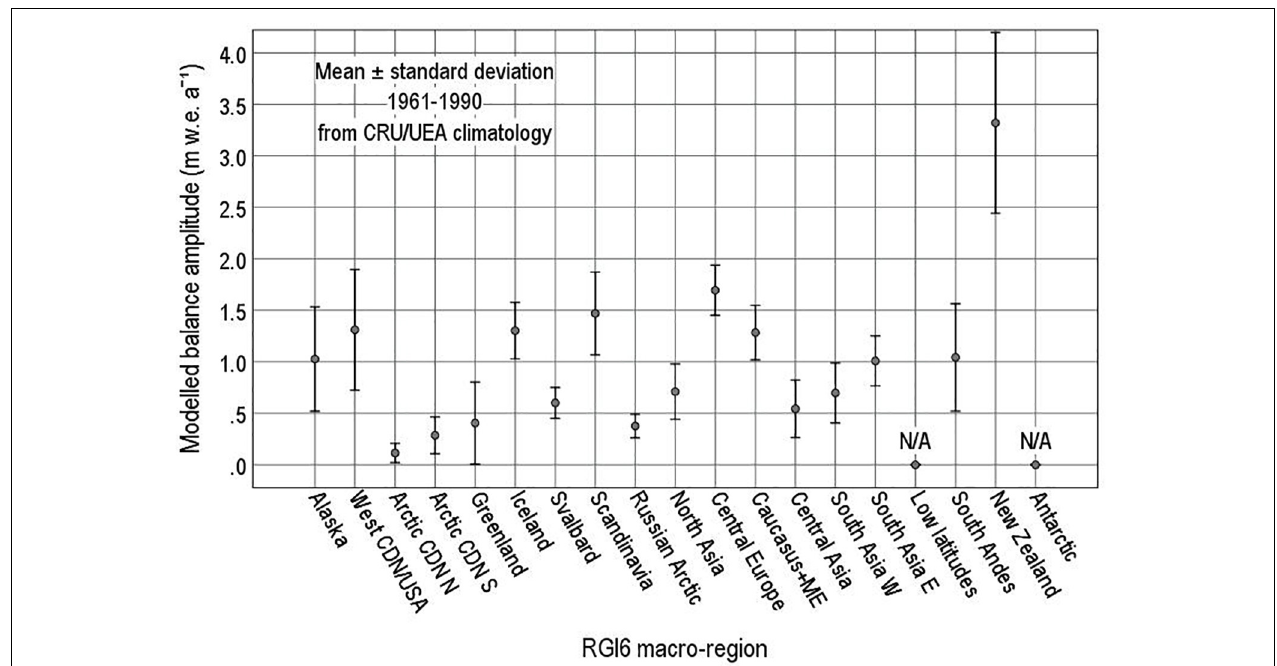
FIGURE 10 | Modelled balance amplitude for 17 macro-regions in the Randolph Glacier Inventory (RGI Consortium, 2017).